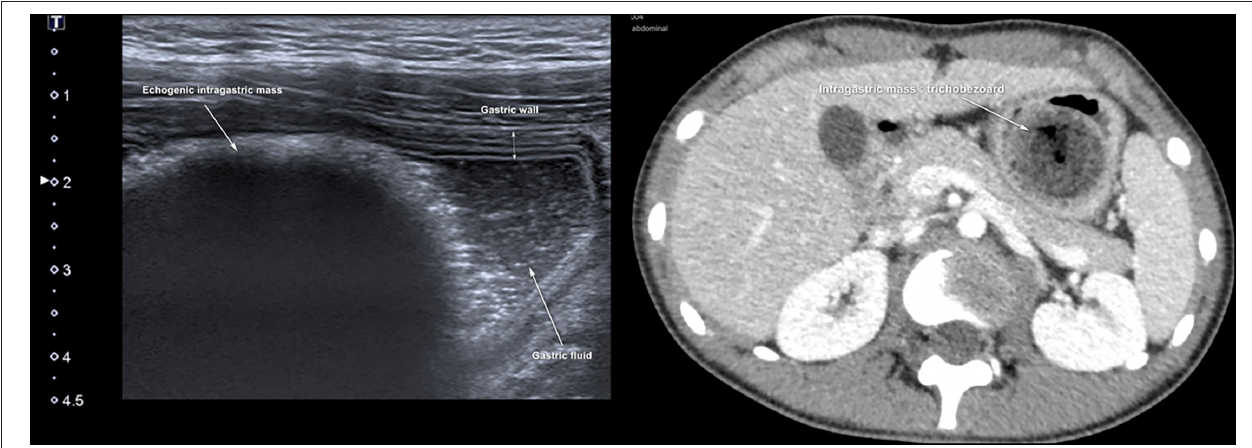
FIGURE 4 | Intragastric foreign body. Large hyperechoic mass within the stomach may suggest the diagnosis of an intragastric foreign body (e.g., voluminous trichobezoar). In an uncertain diagnosis, and before surgery, an abdomino-pelvic CT scan should be performed to examine the extension of the foreign body. Gastric POCUS techniques found in the literature: various ultrasound probes have been used (high- or low-frequency linear or curvilinear transducers) and the child was positioned in a supine and/or a right lateral decubitus to enhance the quality scanning of the thoracic and epigastric areas. Liquid filling may help in visualizing the foreign